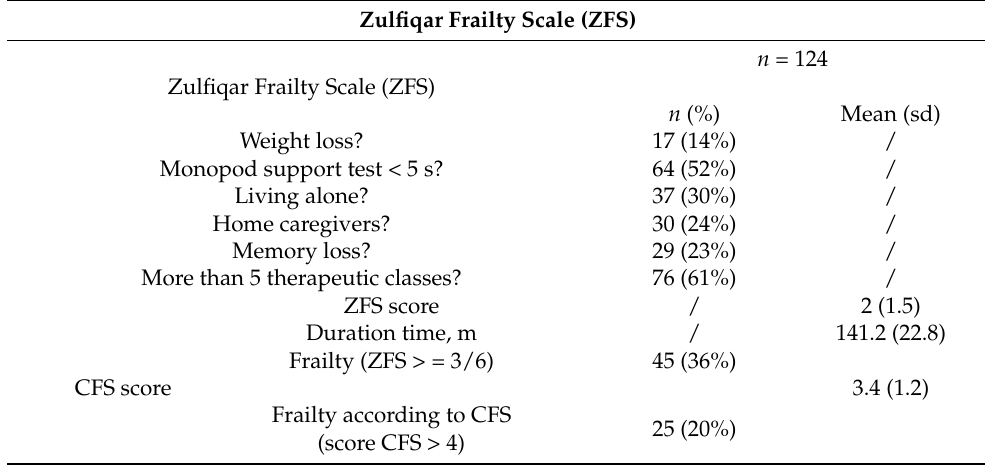
Table 3. Zulfiqar Frailty Scale (ZFS) and Clinical Frailty Scale (CFS).